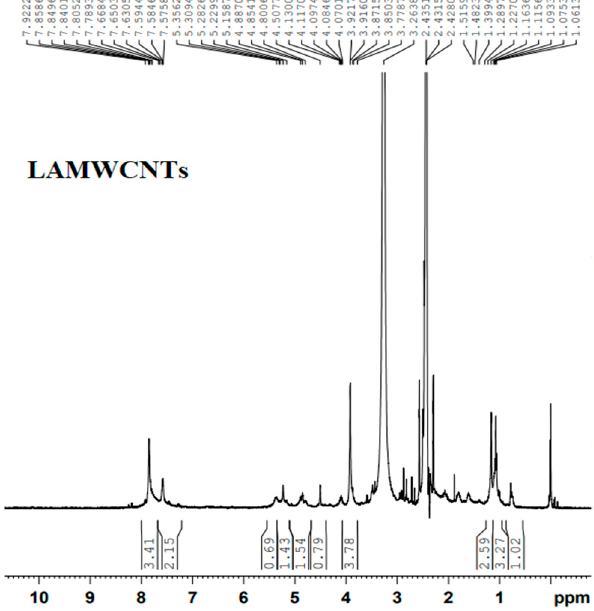
Figure 4. H 1 NMR spectra of the functionalized COOHMWCNTs.